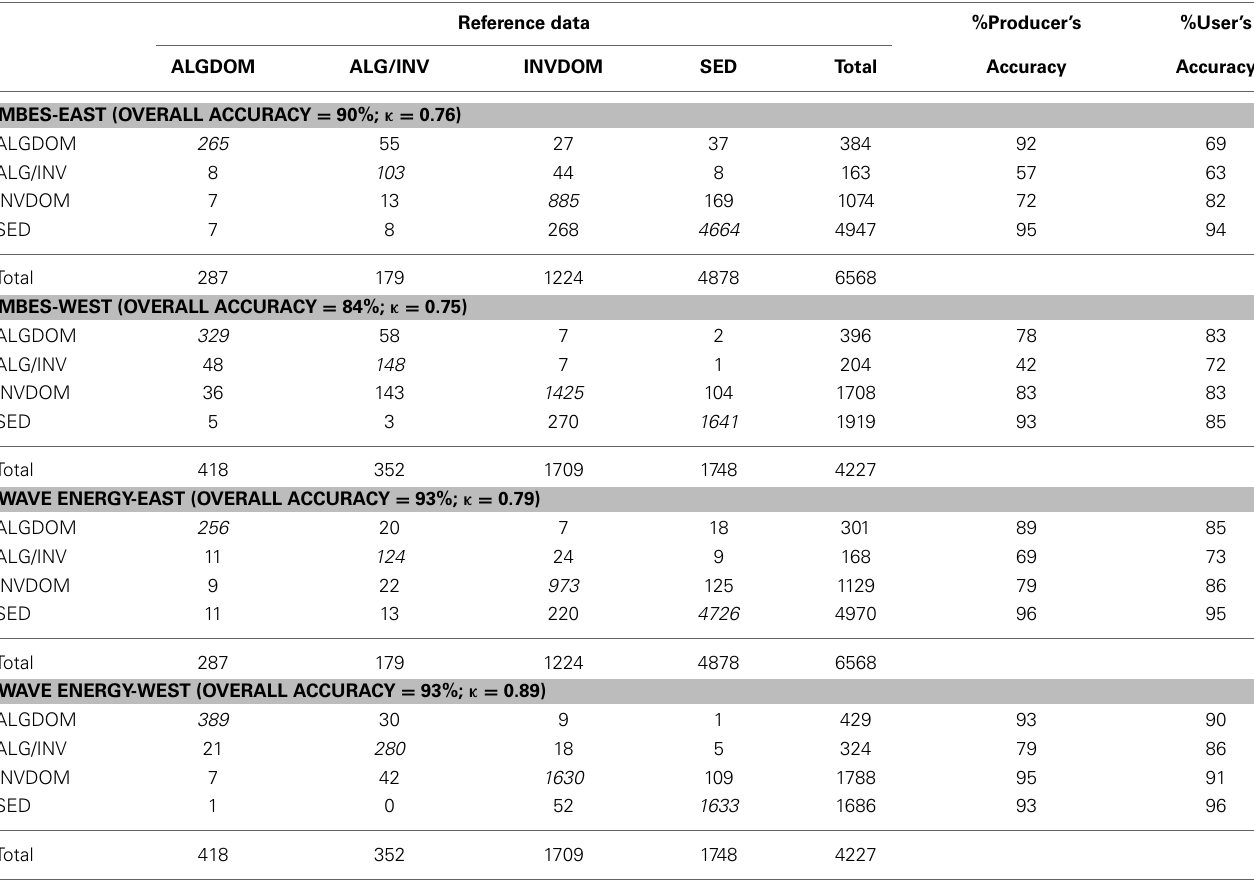
Each column corresponds to the ground reference pixels used for accuracy assessment for a single class. The values in the columns indicate the number of those ground observation pixels classified into each class, while the values on the main diagonal (italicized) indicate agreement between validation data and classified